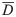
Sequential switching.a) Raster plot associated to the two input protocols I(1) and I(2). The circles denote the clusters of active neurons appearing repetitively after the presentation of the stimulus I(1). Vertical lines denote the switching times between stimuli. The clustering algorithm employed to identify the different groups is applied only during the presentation of the stimulus I(1), therefore the sequential dynamics is most evident for that particular stimulus. b) Averaged State Transition Matrix D¯, obtained by considering a 4Tsw × 4Tsw sub-matrix averaged over r = 5 subsequent time windows of duration 4Tsw (see the section Methods for details). The inputs I(1) and I(2) are different realization of the same random process, they are obtained by selecting N current values Ii from the flat interval [Vth, Vth + ΔV]. The input stimuli are switched every Tsw = 2 s. Number of clusters k = 35 in a). Other parameters as in Fig 1.